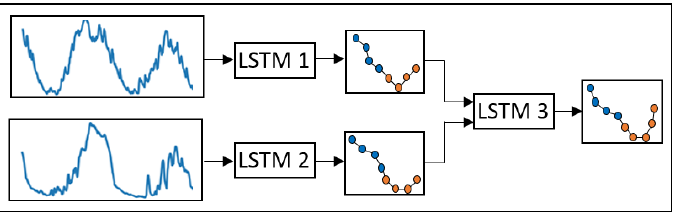
Figure 4. Schematic representation of forecast by the proposed ensemble LSTM model.